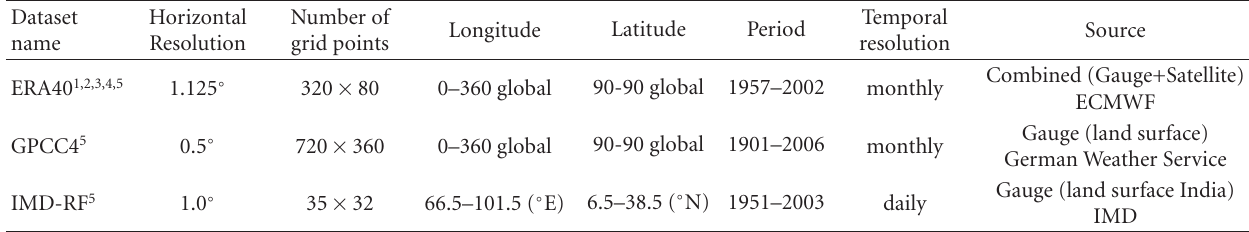
Table 1: Gridded observed data sets used for validation of mean sea level pressure (1), geopotential (2), temperature (3), wind (4), and precipitation